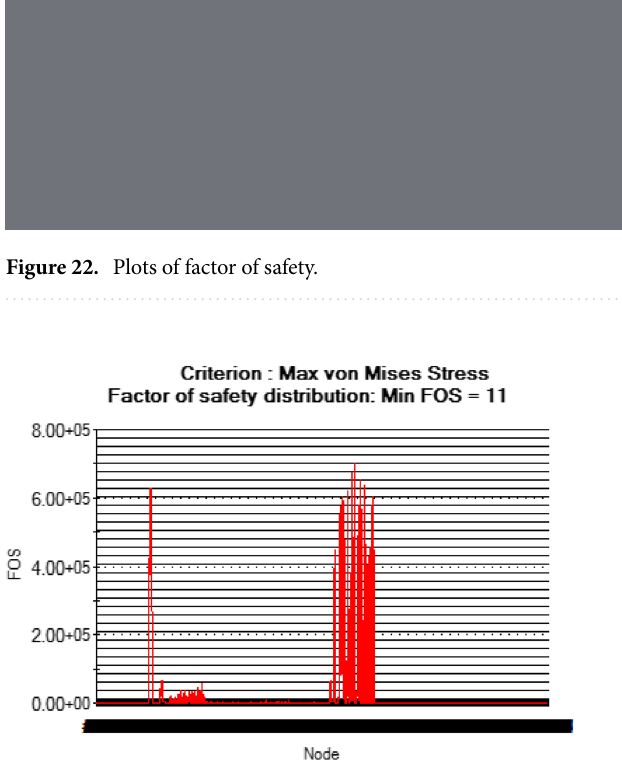
Figure 23. Simulation graph for factor of safety.